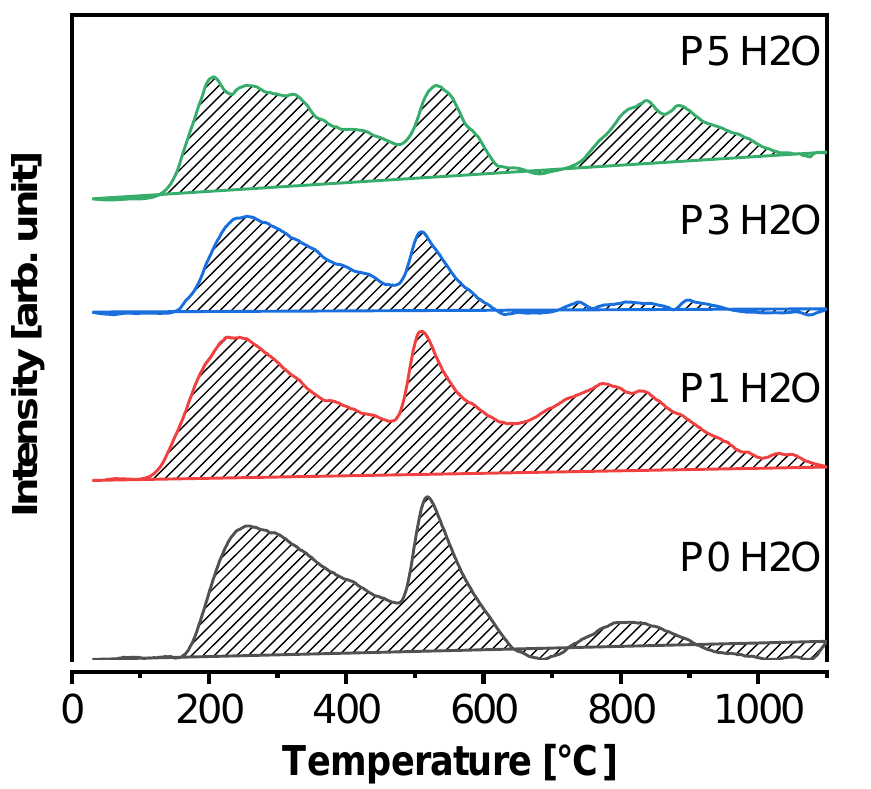
Figure 9. Plots of MS signal of water (m/z = 18) over time of paste samples after 28 days of curing.